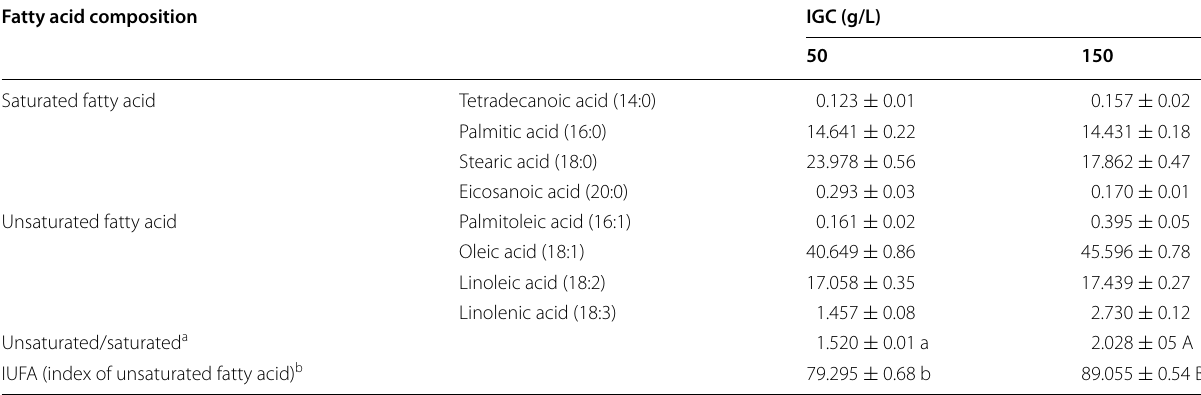
Data are mean a (C18:1 b (C18:1)